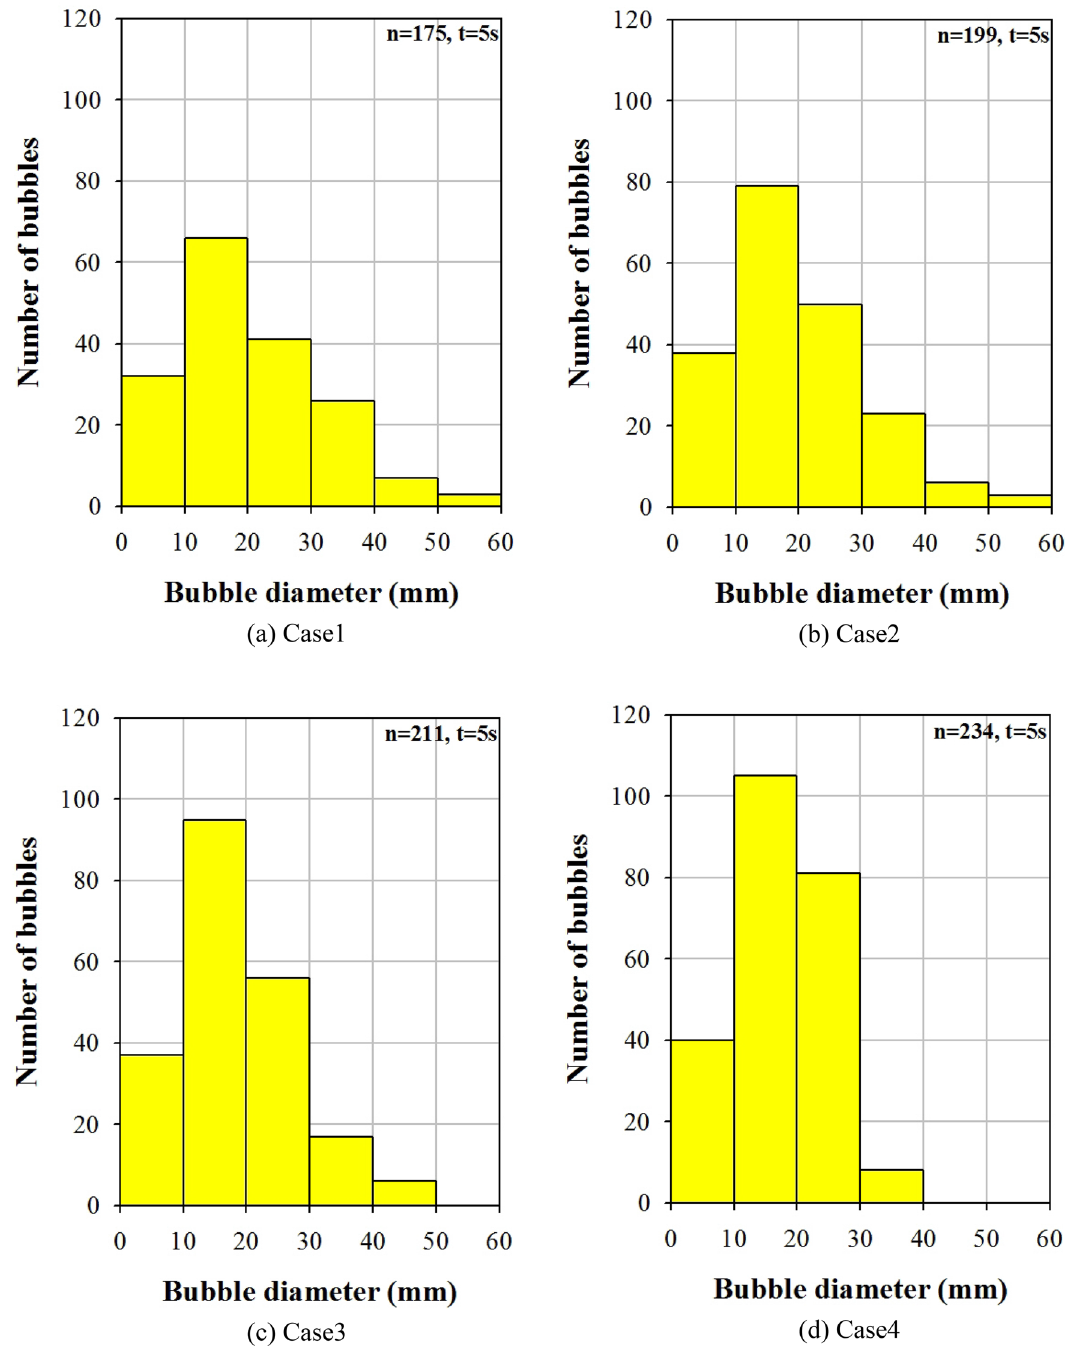
Figure 8. Bubble diameter distributions for different shapes of fluidized bed